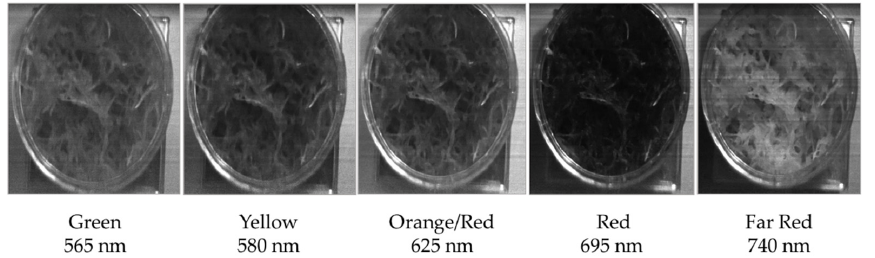
Figure 6. Spatial and spectral dataset of a healthy Sphagnum sample obtained from the High-Resolution instrument. Note the distinct reduction in reflectance in the red related to chlorophyll absorption.